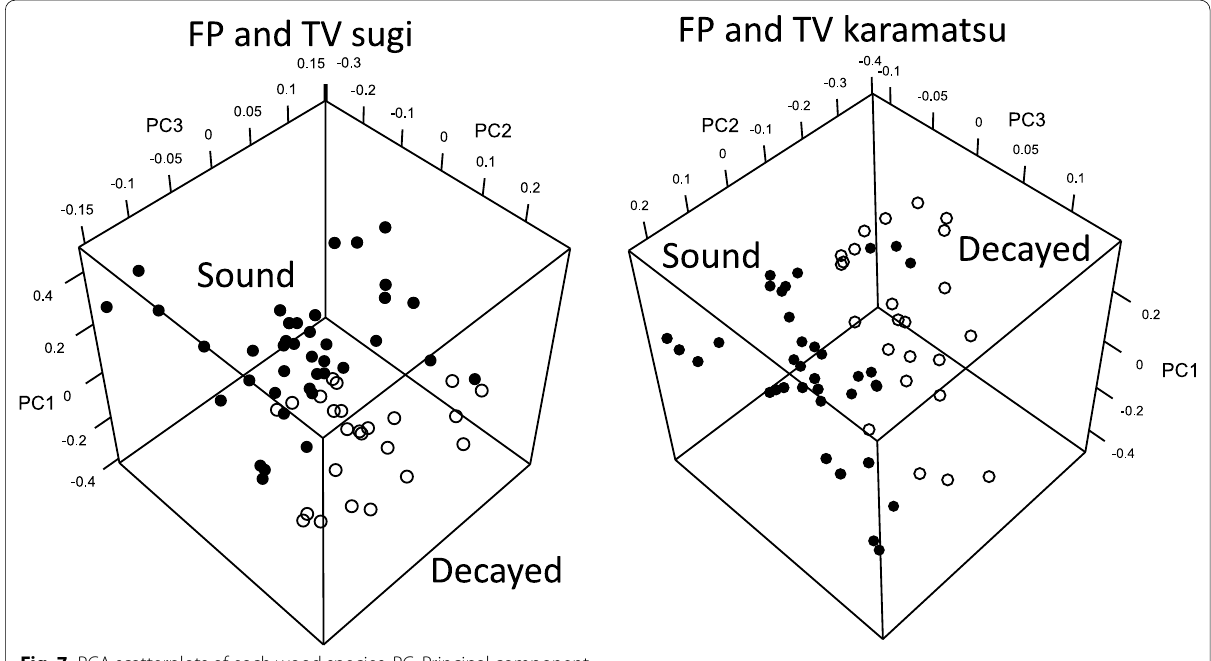
Fig. 7 PCA scatterplots of each wood species. PC: Principal